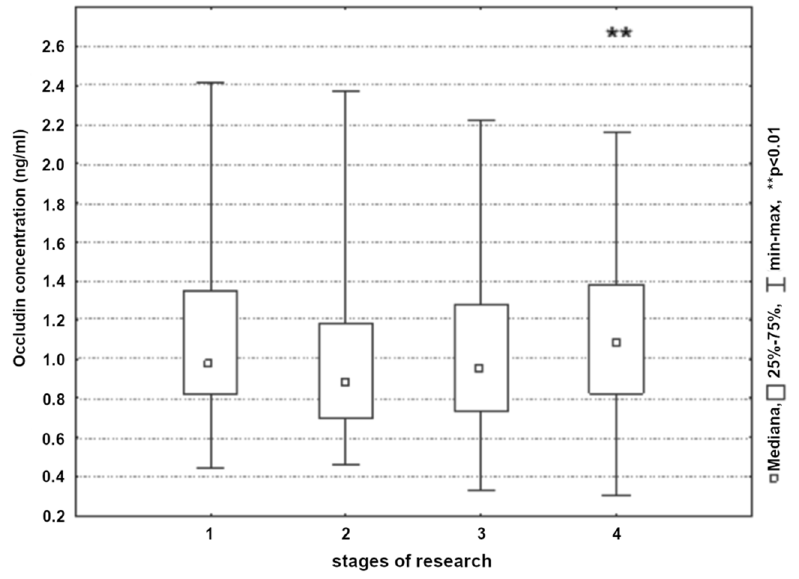
Figure 6. Occludin concentration in patients in the next stages of research (1, 24 h before surgery; 2, 8 h post-surgery; 3, 24 h post-surgery; and 4, 48 h post-surgery).